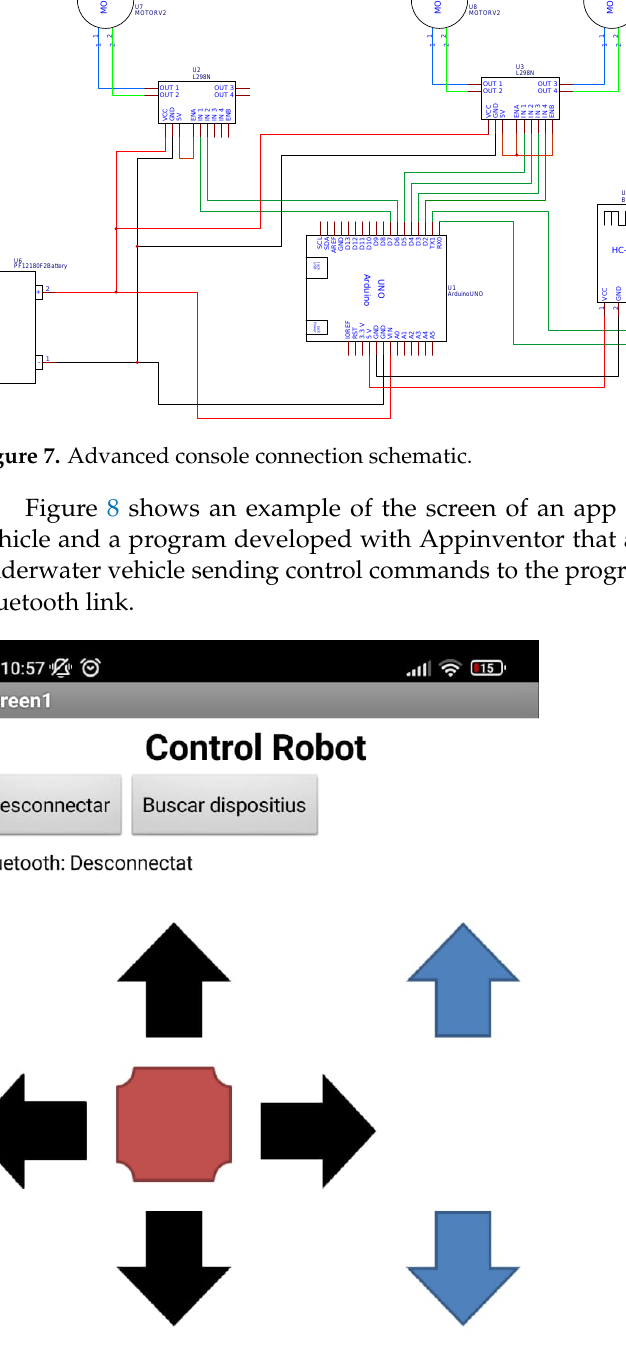
Figure 8. Example of app screen for vehicle control designed with